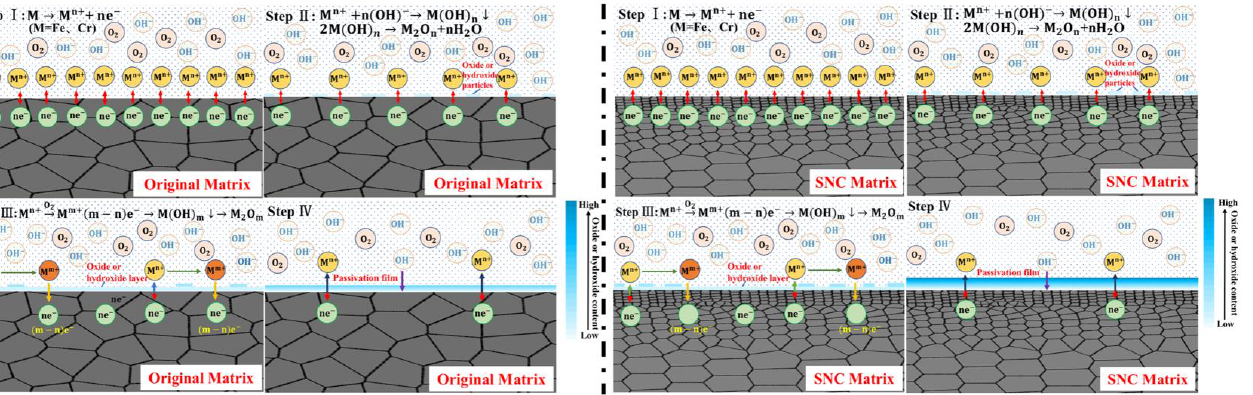
Figure 12. TEM microstructure characteristics of the SNC rebar: ( a ) grain morphology; ( b ) intragran- ular microstructure characteristics.